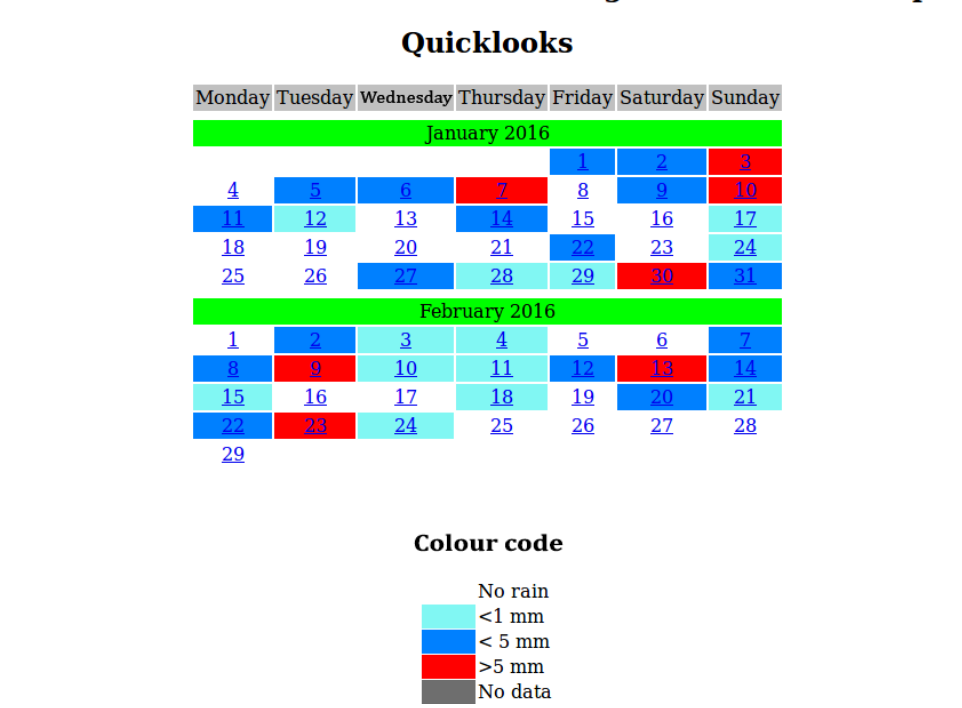
Figure 3. Snapshot of the calendar summarizing the January–February 2016 campaign on the roof of the Carnot building.